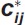
Matrix plots: (a) maximum circular correlation, cij*; (b) time delay, τij*, between all pairs of years (i, j) = 0, …, 63.